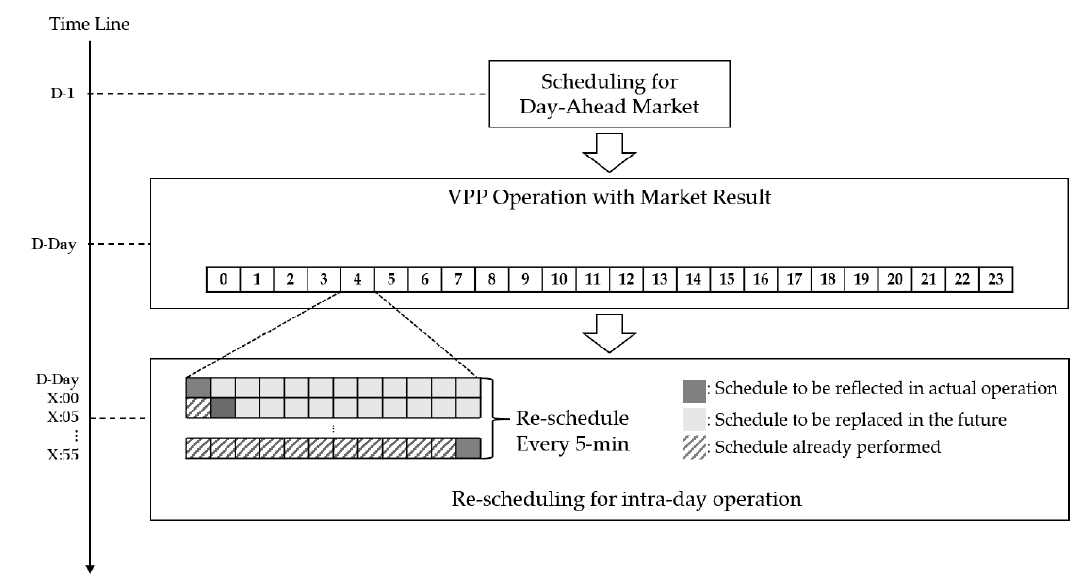
Figure 2. Scheme for bidding-operation scheduling. During ID operation, the schedule is revised every 5 min by considering the updated forecast and PS schedule from the DA market.